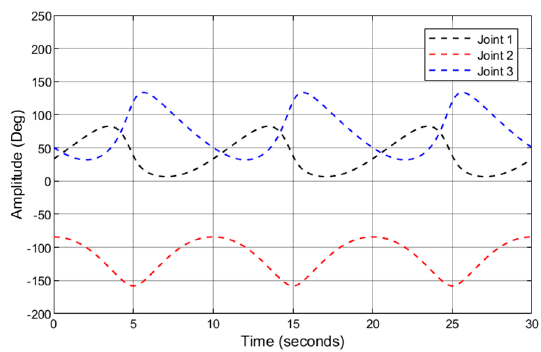
Figure 4. References of the 3-DOF planar manipulator in joint space at 0.1 Hz.